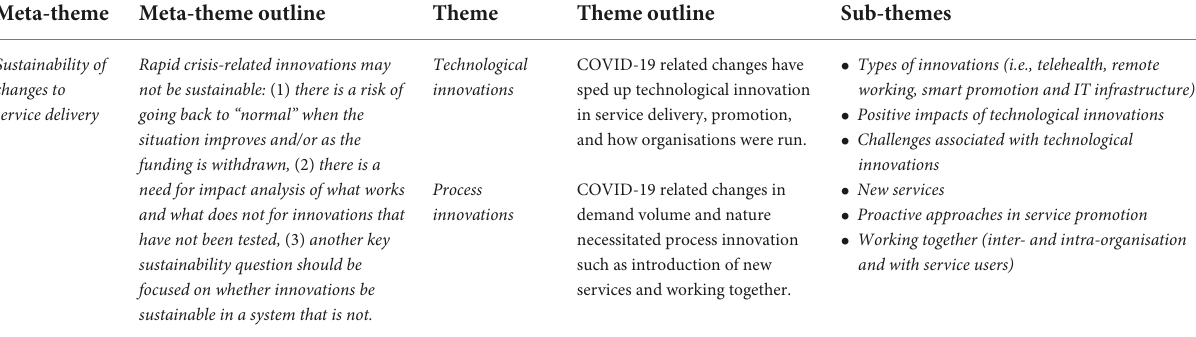
TABLE 2 Themes and sub-themes for qualitative data